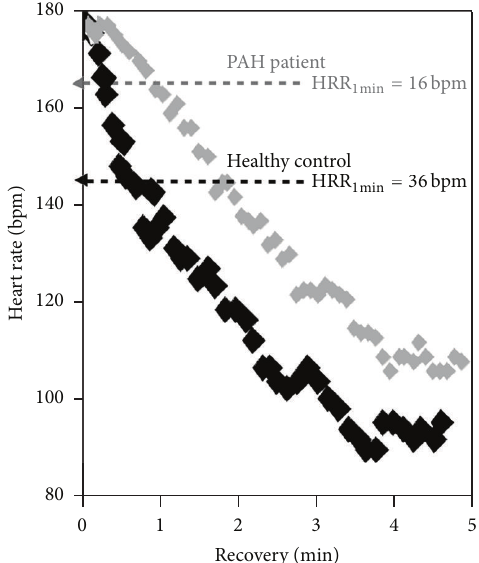
Figure 14: Heart rate ( HR ) response after incremental exercise in a healthy control and a patient with pulmonary arterial hypertension (PAH) of same age and gender (both females aged 31). Note the delayed HR recovery ( HRR ) up to the 5th minute after-exercise in the patient compared to the control. HRR 1min ≤ 18bpm after cycle ergometer exercise test has recently been found an independent predictor of mortality in these patients